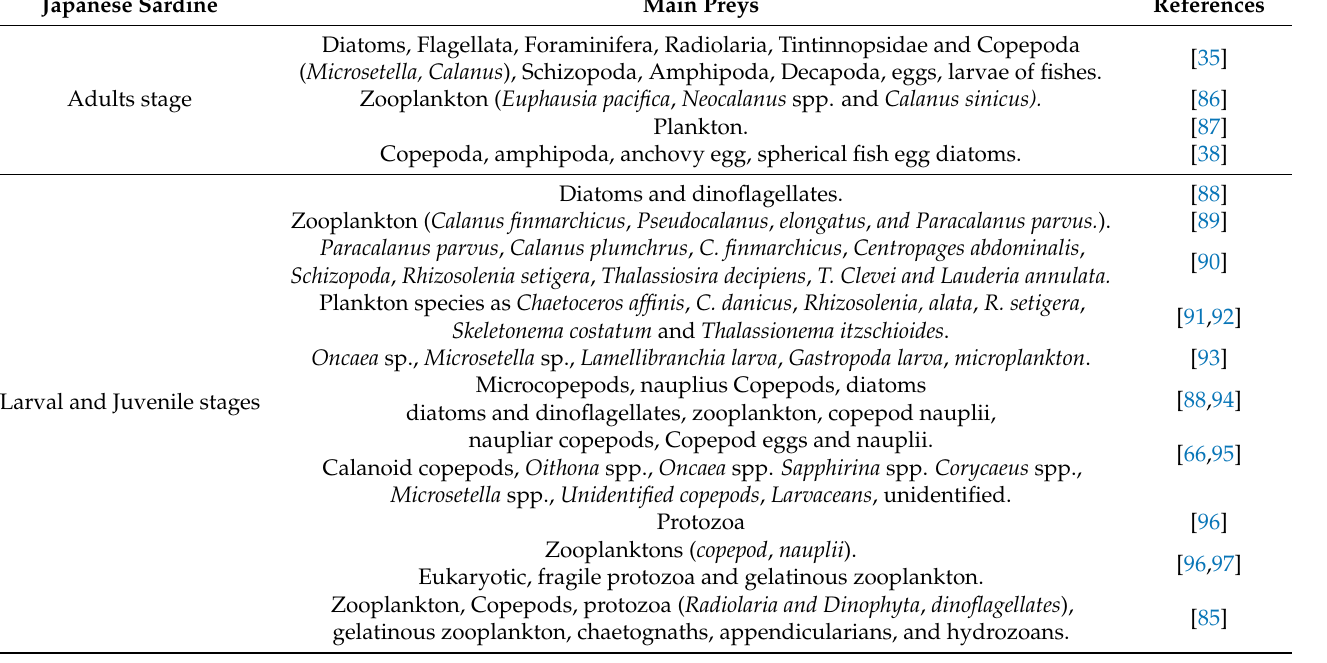
Table 2. Main prey’s composition of larval, juvenile and adult stages of Japanese sardine ( Sardinops melanostictus ). Japanese Sardine Main Preys